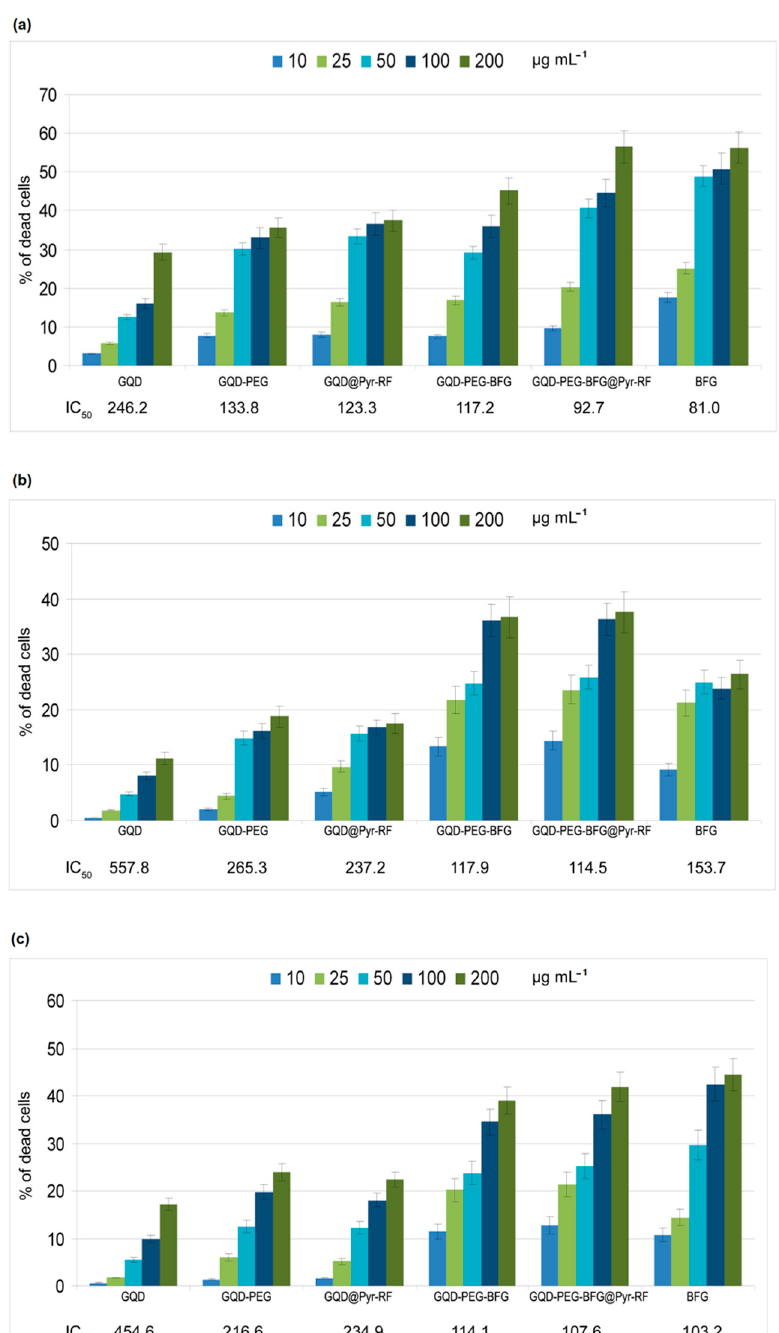
Figure 8. Cytotoxic effect of the synthesized drug delivery nanosystems in ( a ) laryngeal cancer cells HEp-2, ( b ) human lung epithelial cancer cell line A549, and ( c ) the human colorectal adenocarcinoma cell line HT-29. The results, obtained in cells treated for 24 h, are reported as percentages of dead cells (treated/untreated cultures). The concentrations of 10, 25, 50, 100, and 200 µ g mL − 1 , shown at the top of the graphs, are those of GQD-PEG-BFG@Pyr-RF, corresponding to 2.1, 5.25, 10.5, 21, and 42 µ g mL − 1 doses of BGF assayed in the positive controls. For the GQD-PEG-BFG, the assayed doses were calculated to assess the same drug concentrations while for GQD, GQD-PEG, and GQD@Pyr-RF, the examined doses were 10, 25, 50, 100, and 200 µ g mL − 1 . Each value represents the mean ( ± SD) of the experiments made in triplicate for each cell line. In each graph, the corresponding values of IC 50 are reported below.